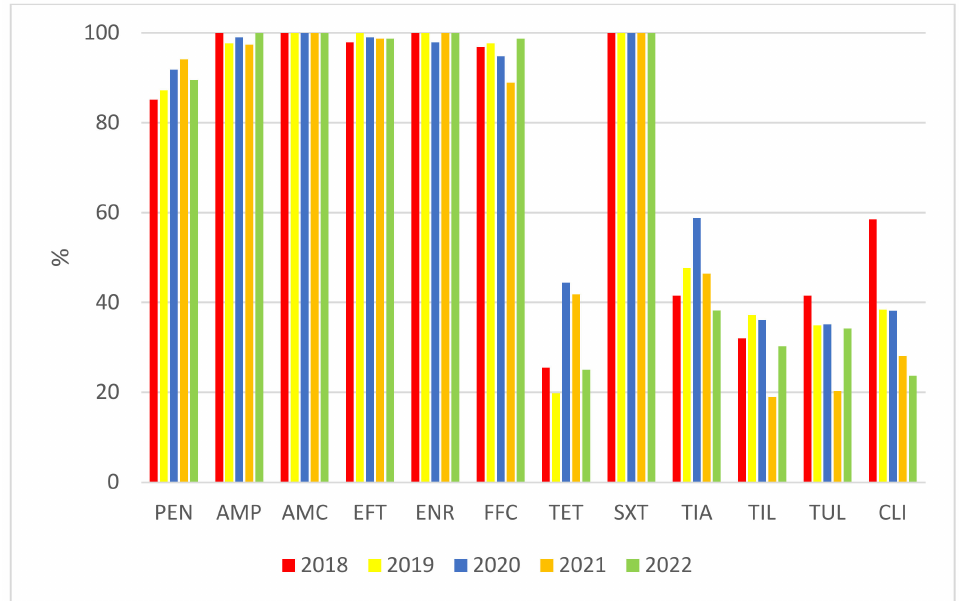
Figure 5. Comparison of the percentages of isolates of S. suis susceptible to the tested antimicro- bials in individual years. PEN = Penicillin; AMP = Ampicillin; AMC = Amoxicillin/Clavulanate 2/1; EFT = Ceftiofur; ENR = Enrofloxacin; FFC = Florfenicol; TET = Tetracycline; STX = Trimetho- prin/Sulfamethoxazole 1/19; TIA = Tiamulin; TIL = Tilmicosin; TUL = Tulathromycin; CLI = Clin-